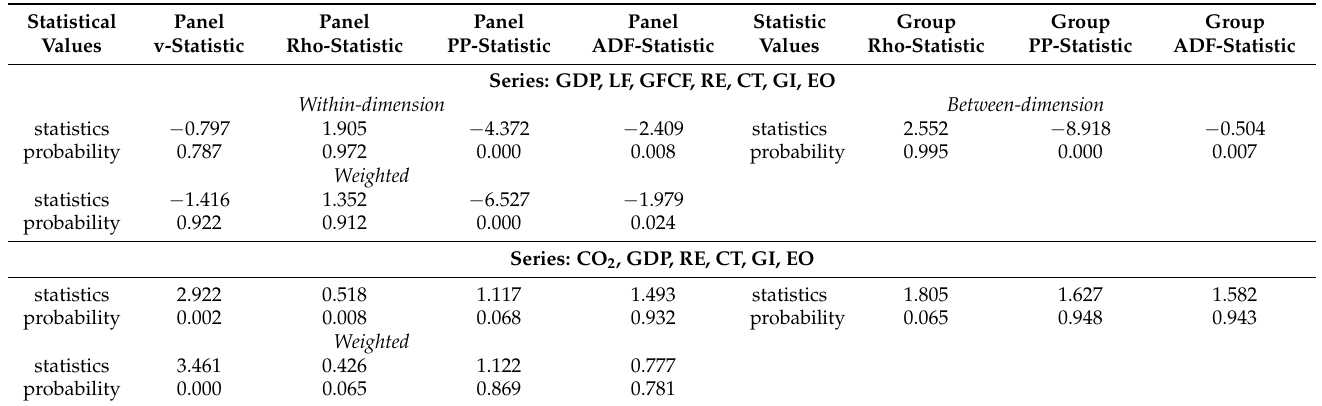
Table 4. The empirical results of the Pedroni panel cointegration.